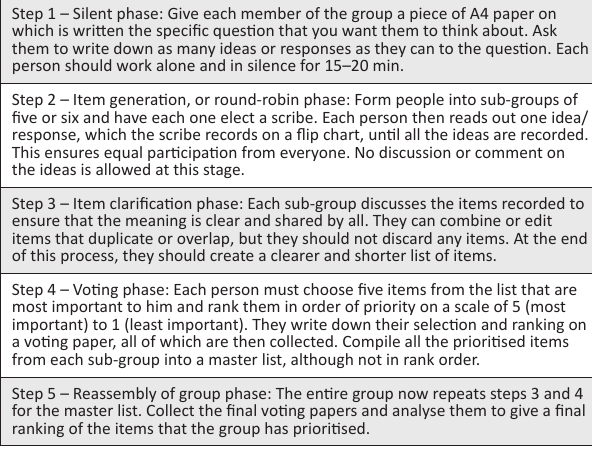
Geographic delinea(cid:18)on